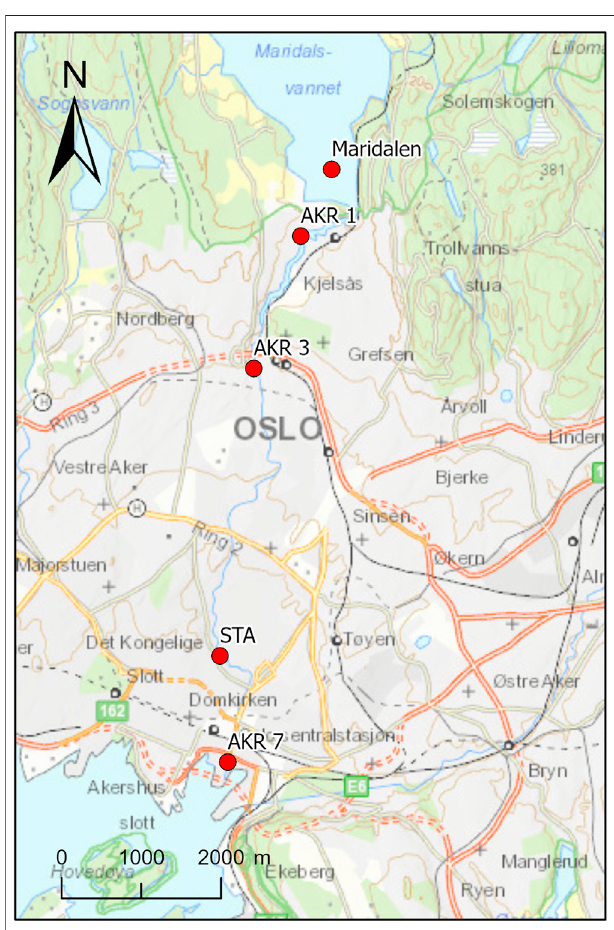
FIGURE 1 | Map of the Aker River and the sampling stations included in this